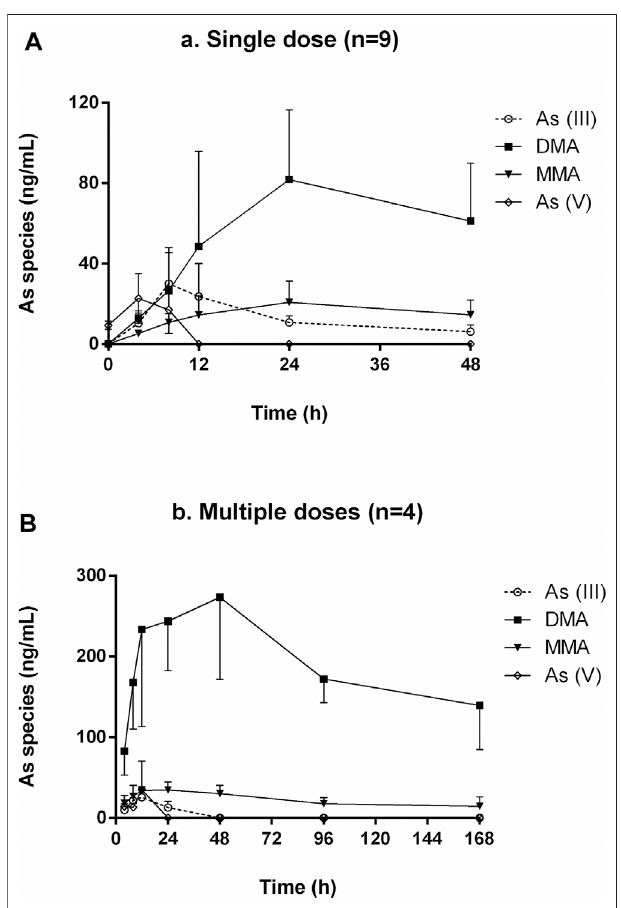
FIGURE5| Concentration-timecurves ofAs (III), DMA, MMA, and As(V) in human urine after oral administration of NHJDT. (A) . single dose ( n (cid:1) 9); (B) . multiple doses ( n (cid:1)